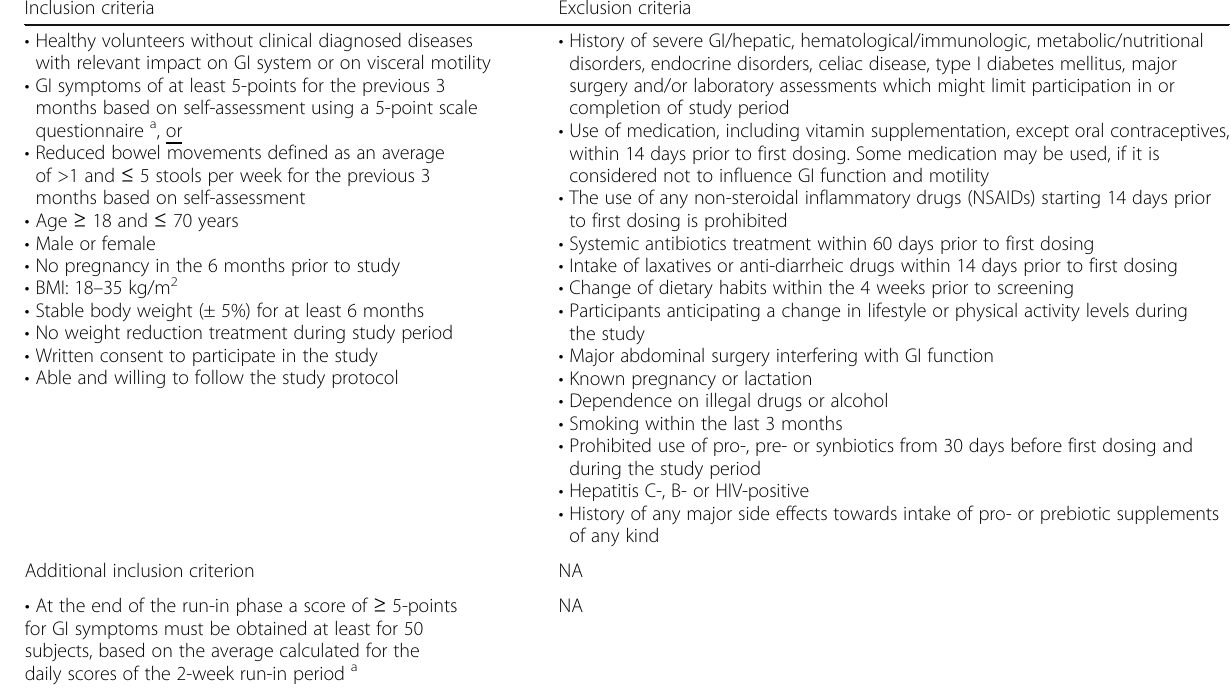
Table 1 List of inclusion and exclusion criteria for participation in the study Inclusion criteria Exclusion criteria